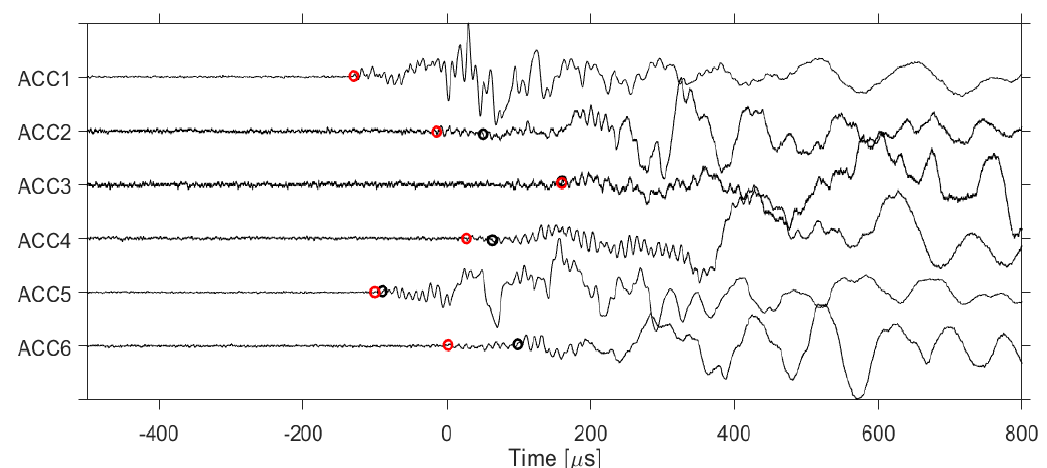
Figure 11. The normalized waveforms generated at pile foundation of node #2 and estimated onset time determined by 1st and 2nd AIC function at six different accelerometers. The onset times determined by the 1st and 2nd AIC function were marked with a black and red hollow dot. The amplitude of each signal was normalized with its peak amplitude for comparison.